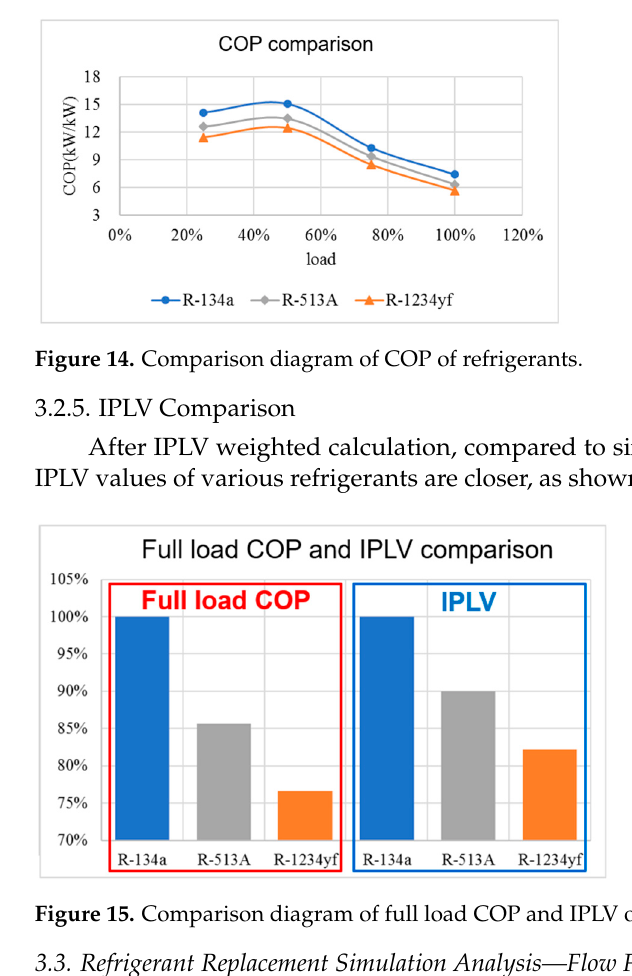
Figure 13. Comparison diagram of shaft power of refrigerants .